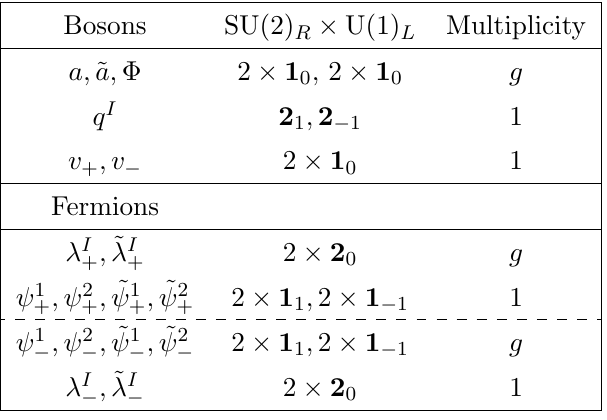
Table 4 . Spectrum of the 2d N = (0 ; 4) theory. The U(1) L charges are only relevant for the